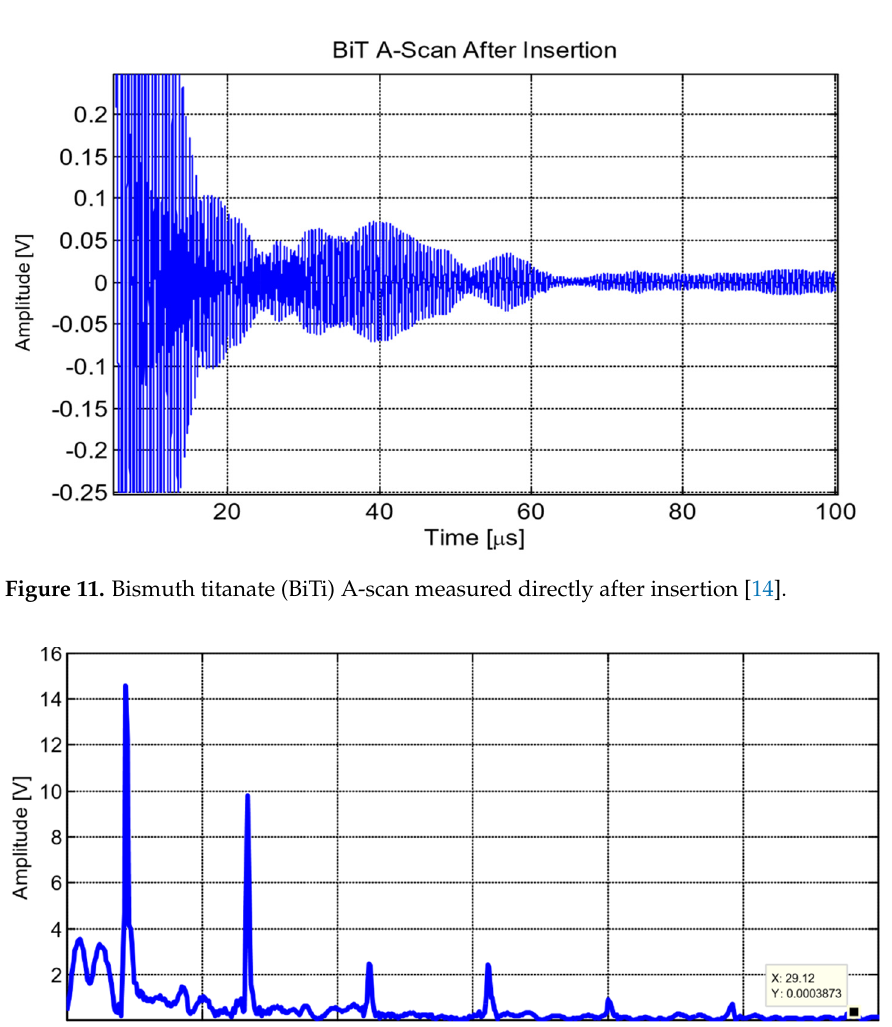
Sensors 2021 , 21 , 6094 9 of 16 10. Bismuth Titanate (BiTi) Sensor Results 10.1. Ultrasonic Measurements The bismuth titanate transducer was pulsed periodically using the LabVIEW system described in the in-pile ultrasonic measurement section. The pulser/receiver sampled the sensor output at 1 GS/s for a period of 100 µs. The pulser was set to a repetition rate of 1 kHz and a total of 256 measurements were averaged for each measurement. A total of 5038 measurements were obtained during the irradiation, with measurements being per-